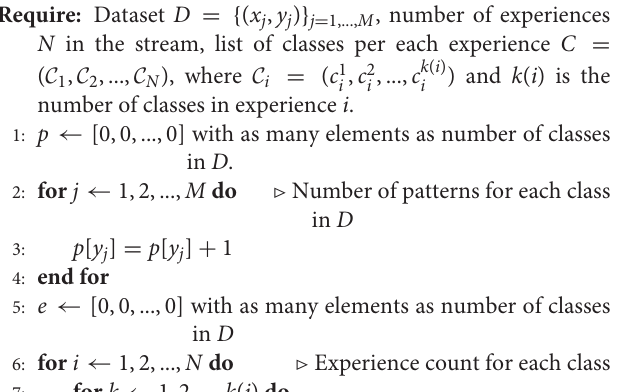
Algorithm 1: Protocol to build class-incremental with repetition benchmark from existing classification